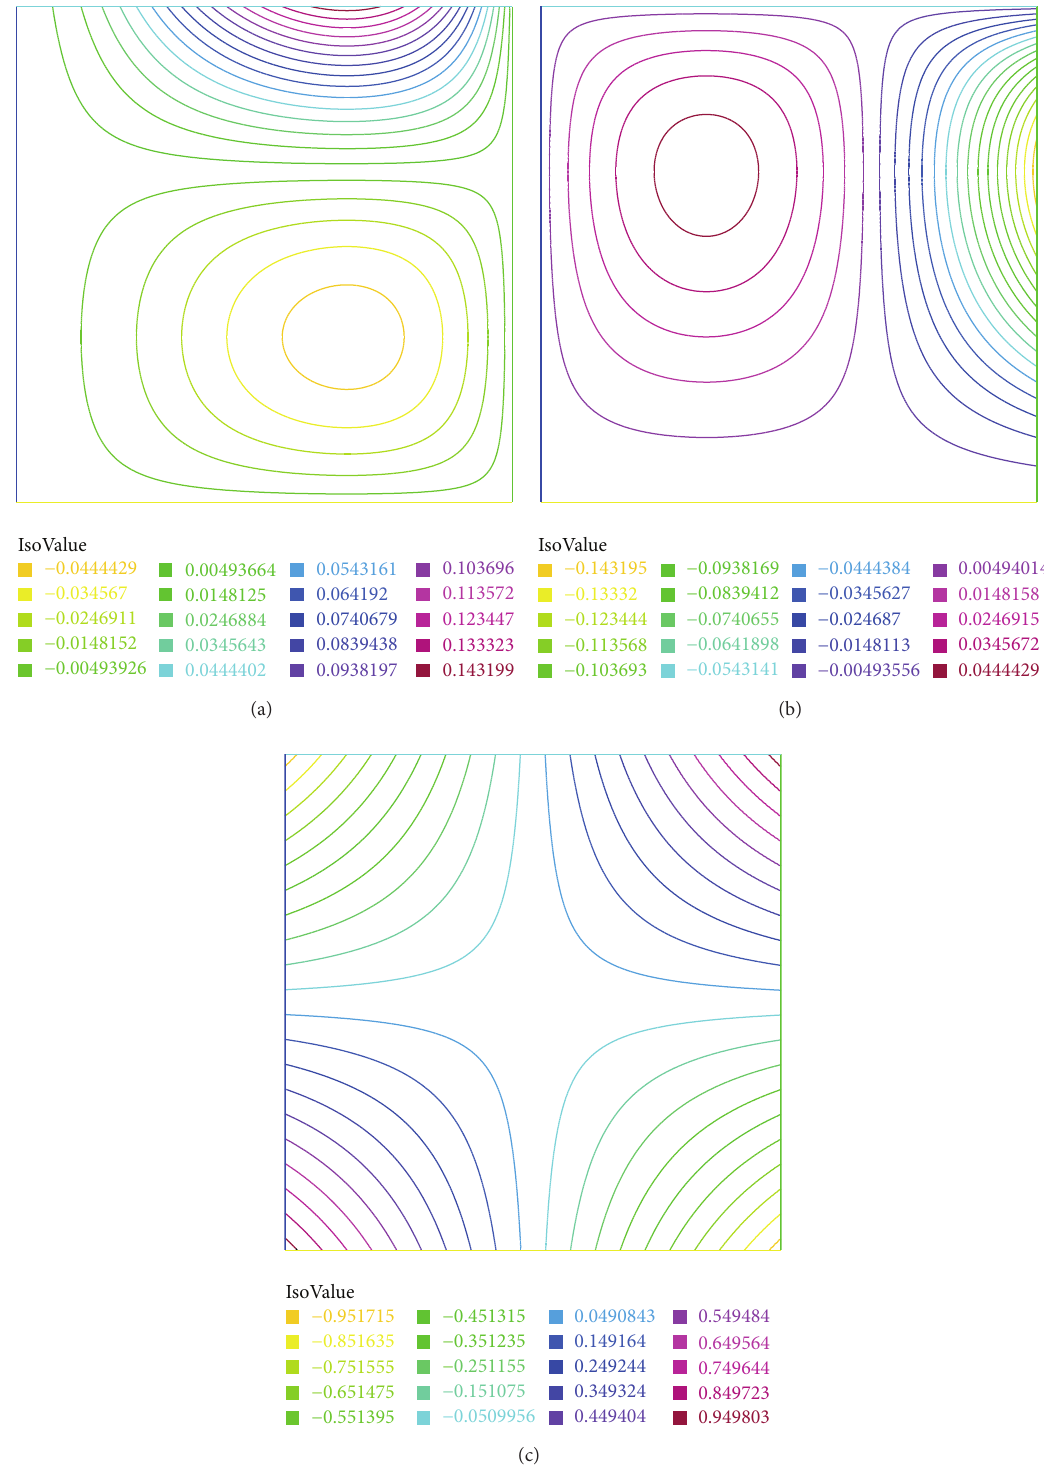
Figure 4: Contour plots of numerical solution by two-level Newton method. From (a) to (c): two components of velocity and